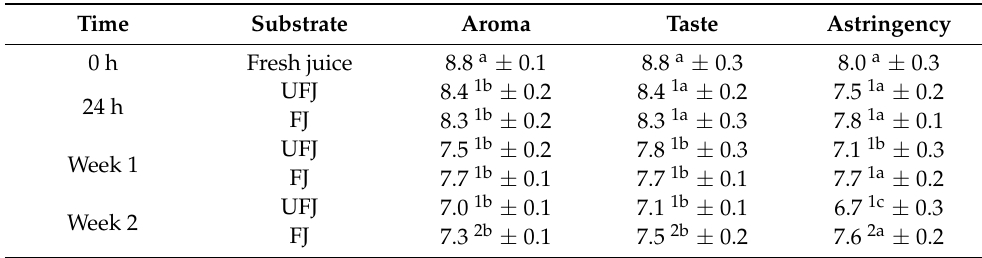
Table 3. Preliminary sensory evaluation of fermented (FJ) and non-fermented (UFJ) pomegranate juice after fermentation (24 h at 30 ◦ C) and over 4 weeks of storage at 4 ◦